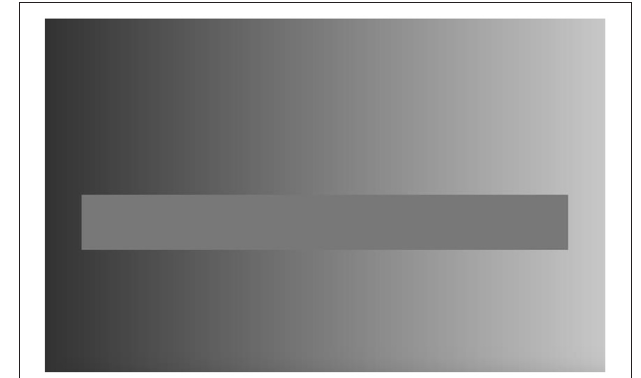
FIGURE 3 | Human-expression Rubin’s vase (http://ms-raz.com/rubins- vase--retrieved 13/6/2020).